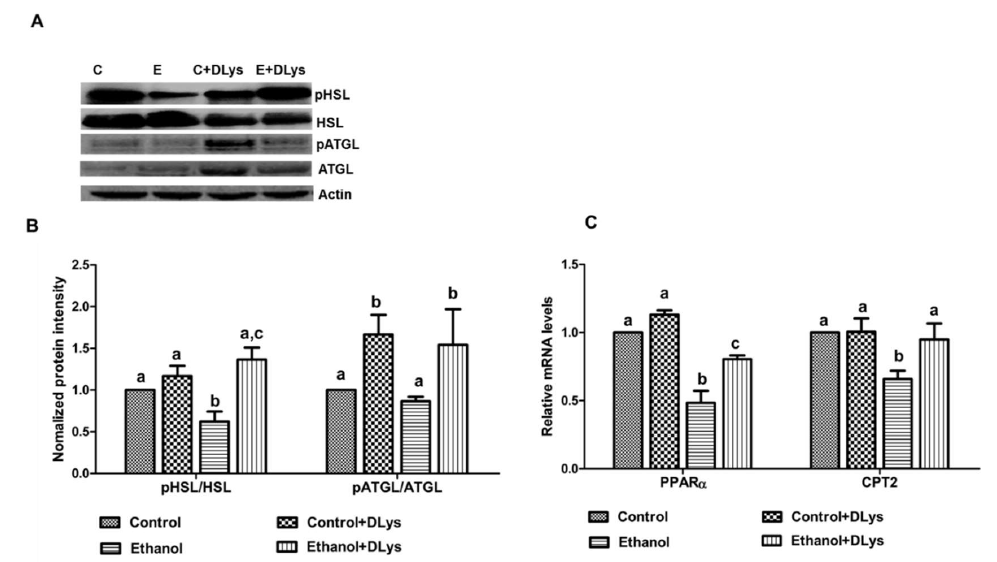
Figure 4. Quantitative analysis of hepatic lipid breakdown and oxidation. ( A ) Representative western blots from control (C), ethanol (E), control + DLys (C + DLys), and ethanol + DLys (E + DLys). ( B ) Densitometric ratios of active (phosphorylated) to total hormone-sensitive lipase (HSL) and adipose triglyceride lipase (ATGL) in the liver of experimental rats. ( C ) qRT–PCR analysis of hepatic gene expression related to fatty acid oxidation-peroxisome proliferator-activated receptor α (PPARα) and carnitine palmitoyltransferase 2 (CPT2). Values are expressed as relative to the control. Values are means ± SEM, n = 8. Values not sharing a common letter are statistically different, p ≤ 0.05.